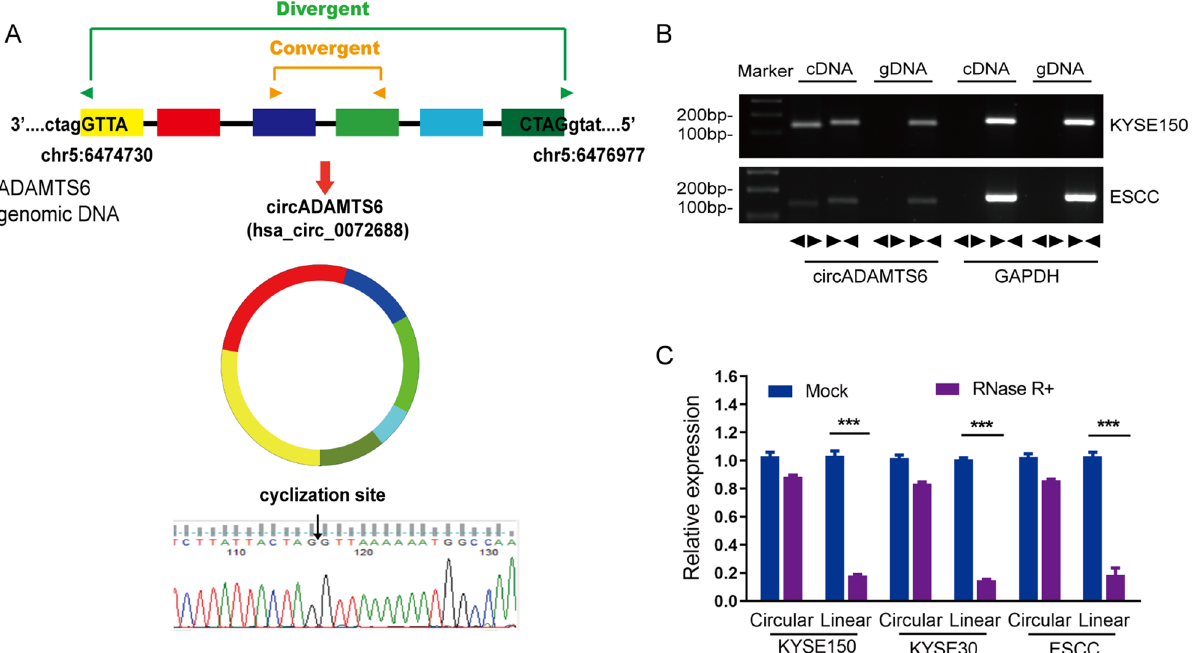
Figure 1. The characteristics of circADAMTS6 in ESCC cells. ( A ) circADAMTS6 is formed by reverse splicing of exons 2–7 in the ADAMTS6 gene. ( B ) The existence of circADAMTS6 in ESCC cell and tissue was confirmed. CircADAMTS6 was only amplified by divergent primers in cDNA but not in gDNA. GAPDH was acted as a linear RNA control. Divergent primers or convergent primers were indicated by the opposite or the same directions of the arrowhead. ( C ) RT-PCR assessed the expression levels of circADAMTS6 and linear mRNA upon RNase R treatment in ESCC cells and